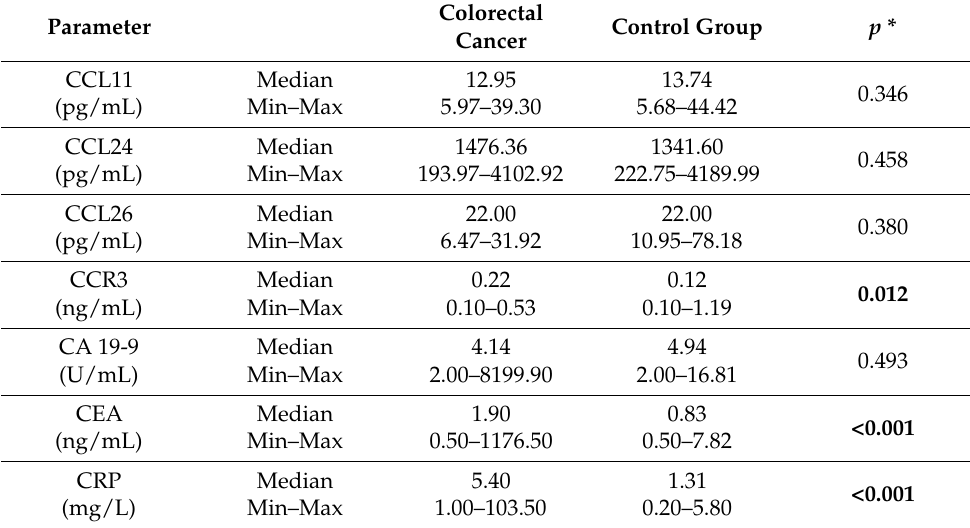
Table 1. Serum levels of tested parameters in cancer and control